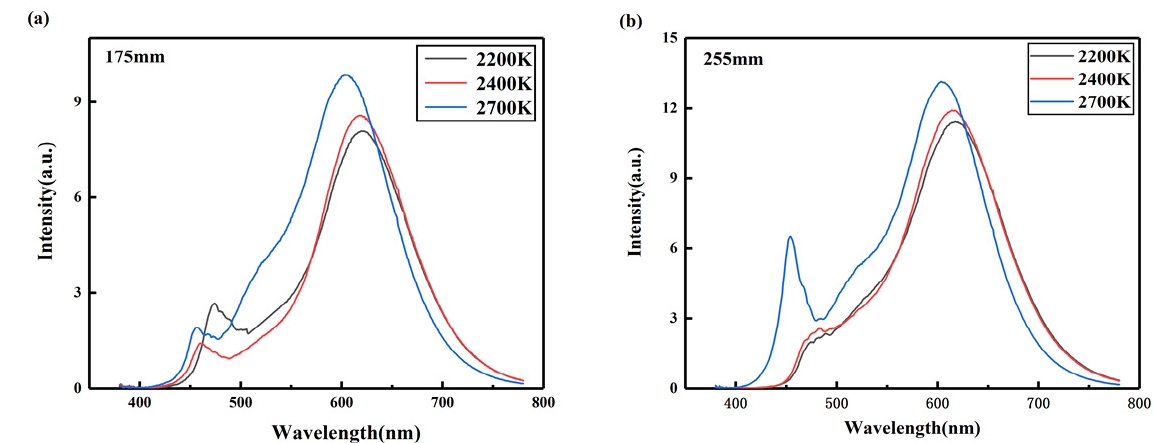
Figure 2. Electroluminescence spectra of ( a ) 175 mm LED filament and ( b ) 255 mm LED filament with CCTs of 2200 K, 2400 K and 2700 K.